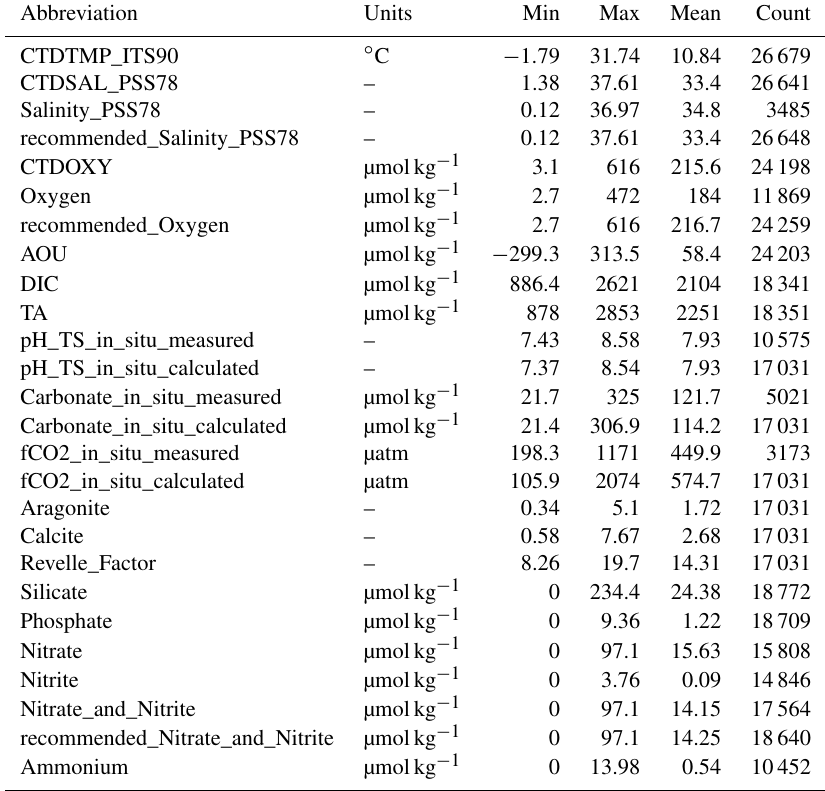
Table 5. The minimum, maximum, mean, and data point counts of the parameters that are included in the final product. Refer to Table 2 for their full parameter names and